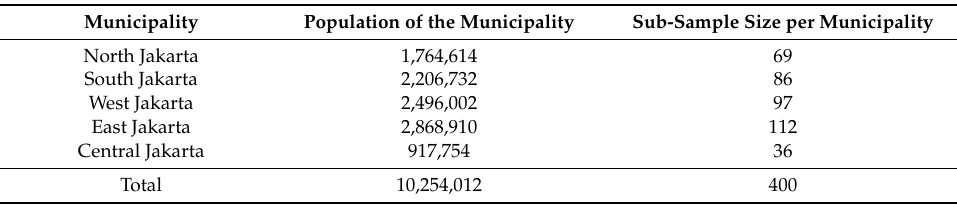
Table 3. The sub-sample size per municipality of Jakarta